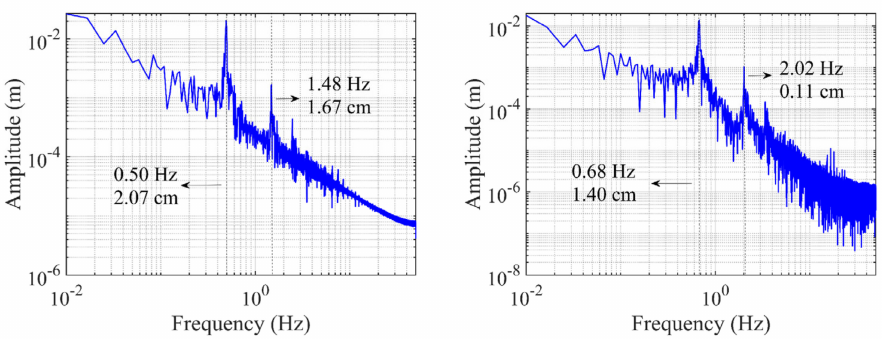
Figure A4. Amplitude-frequency spectra derived from the 100-Hz LDT data for the first (left) and second (right) sinusoidal motion